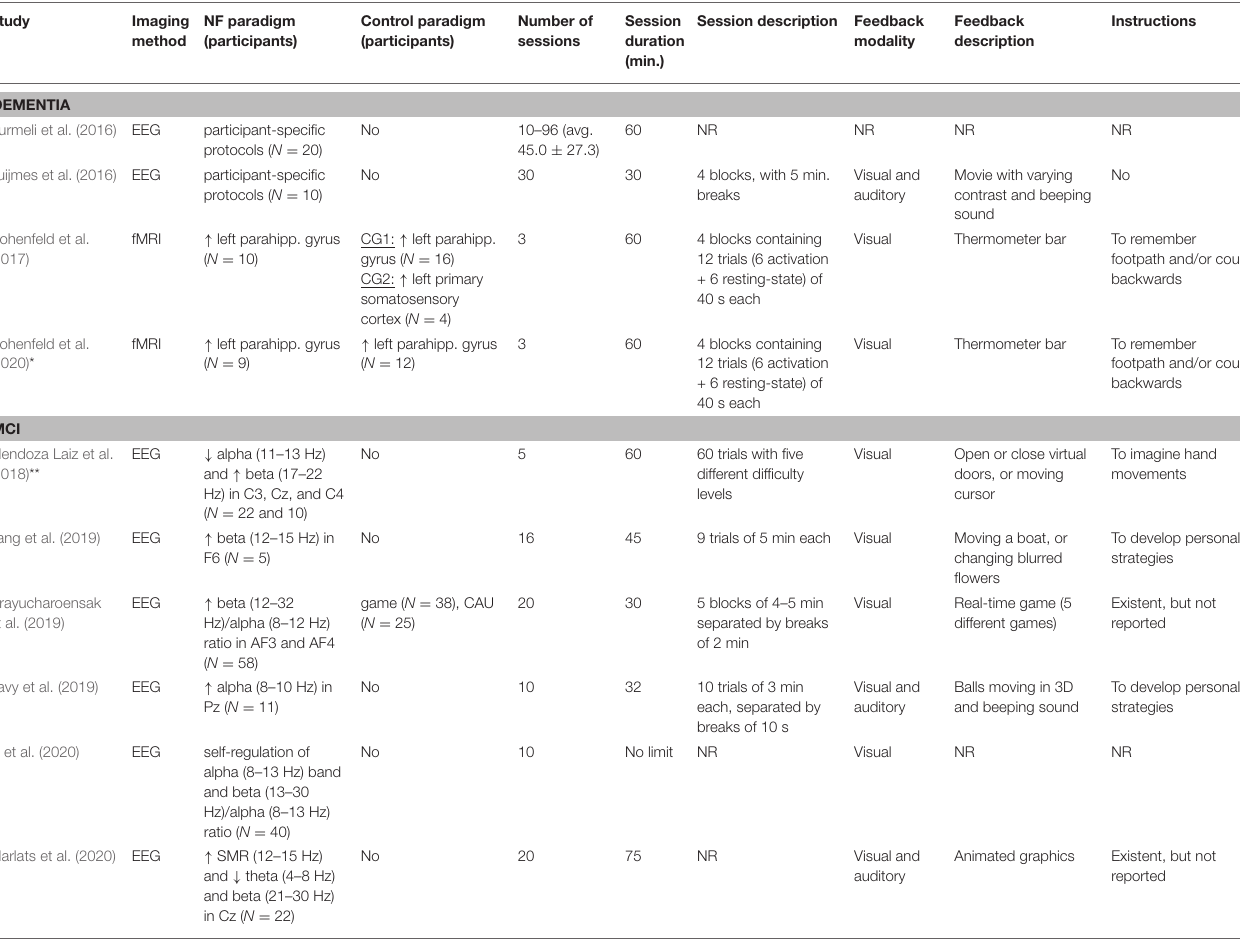
TABLE 4 | Summary of each neurofeedback protocol employed. Study